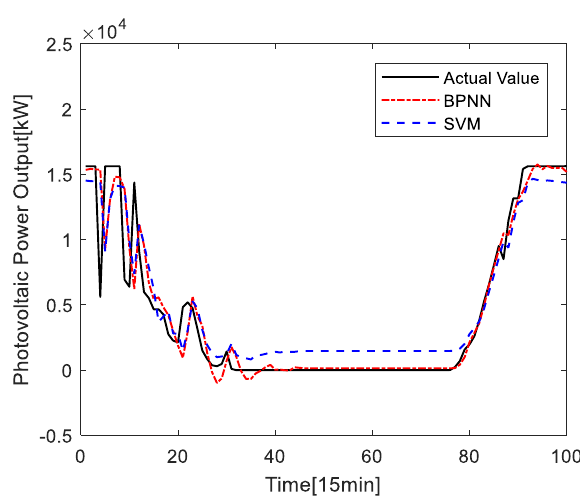
Figure 17. Prediction results of photovoltaic power output in the No. 1 power system.